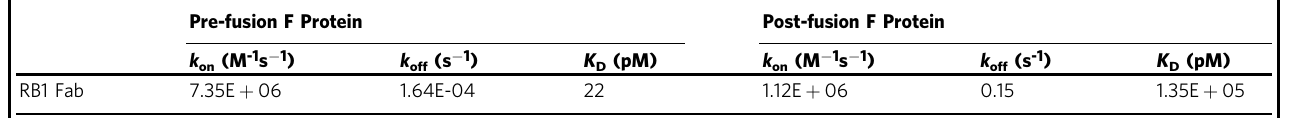
Table 1 SPR Af fi nity determination for RB1 binding to pre and post-F proteins Pre-fusion F Protein Post-fusion F